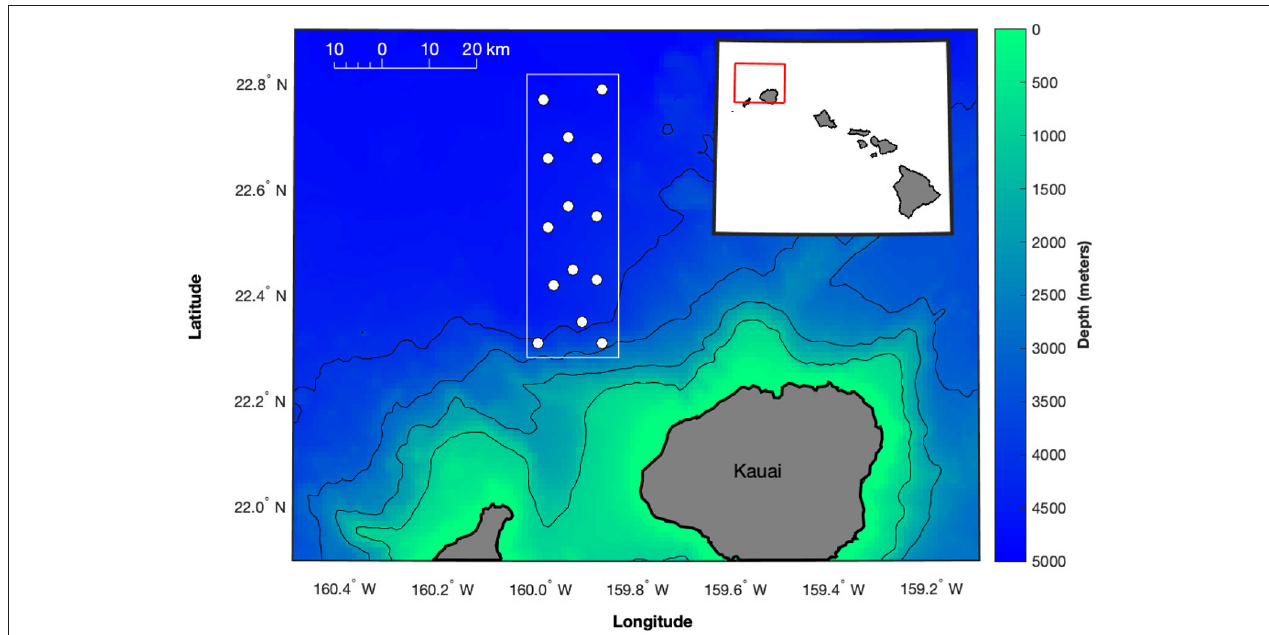
FIGURE 1 | Map of the approximate locations of the 14 hydrophones (white circles) used in this study from the U.S. Navy Pacific Missile Range Facility (PMRF) off Kauai, Hawaii, as shown by the red box in the inset map. The hydrophone array covers an area ∼ 20 km to the east-west and 60 km to the north-south (boundaries shown by white box). Depth contours are every 1,000 m (1 km spatial resolution, Hawaii Mapping Research Group, The School of Ocean and Earth Science and Technology, The University of Hawaii at Manoa, http://www.soest.hawaii.edu/hmrg/multibeam/bathymetry.php) with hydrophones at depths between 3,000 and 4,700 m. Aside from the southernmost 3 hydrophones, the rest of the array is in gently sloping deep